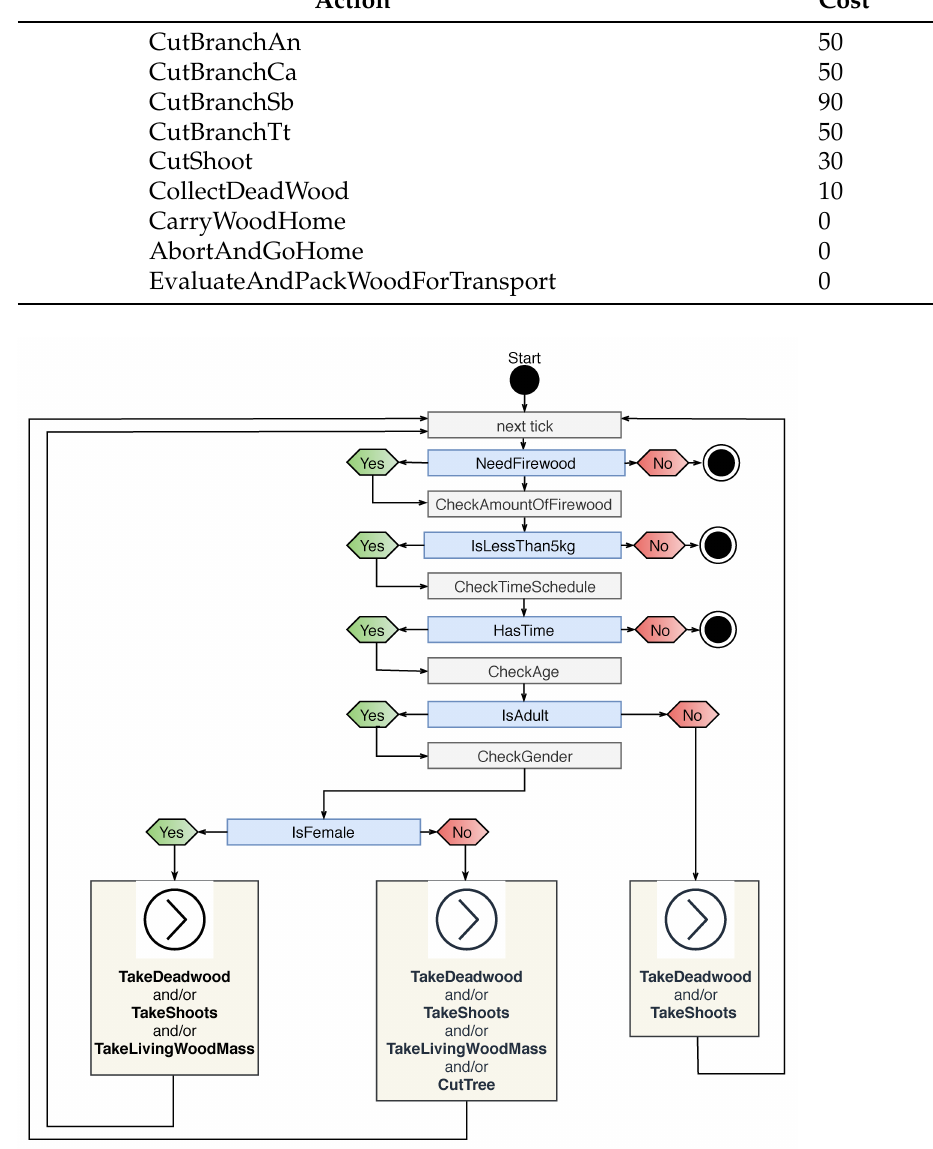
Figure A4. Daily tick routine for FirewoodCollector.